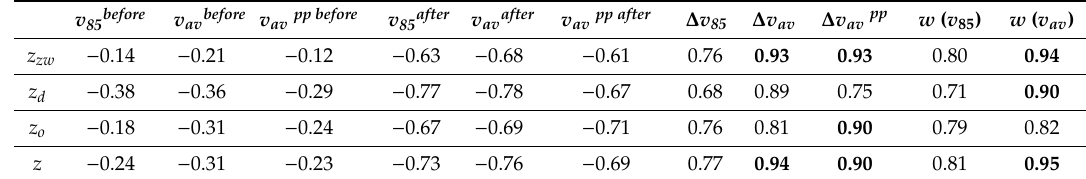
Table 2. Coe ffi cients of correlation R between the quantitative measures and the chosen speed distribution parameters (including additional sections where chicanes were not installed).